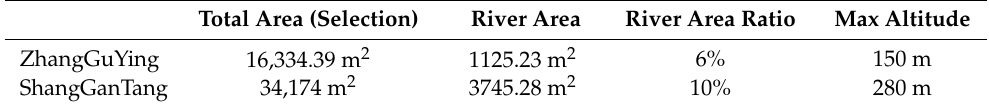
Table 3. The table of 3D model water catchment area